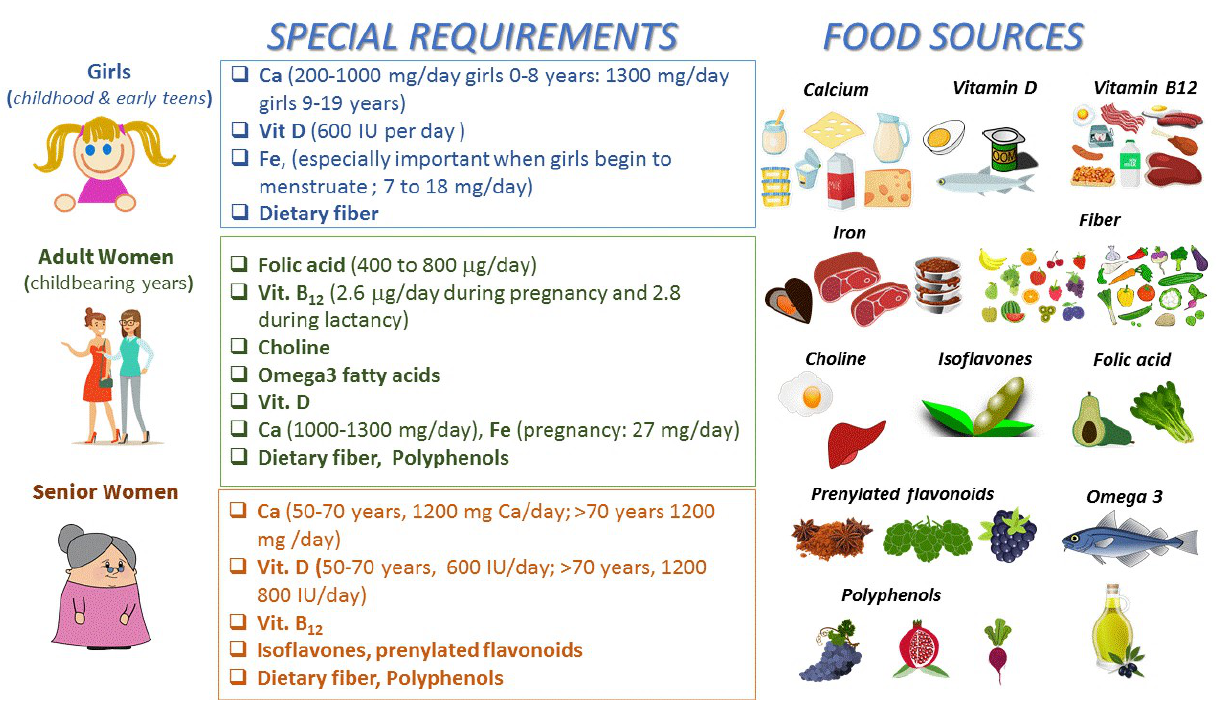
Figure 1. Special nutritional requirements for woman depending on age and physiological state, as well as their main food